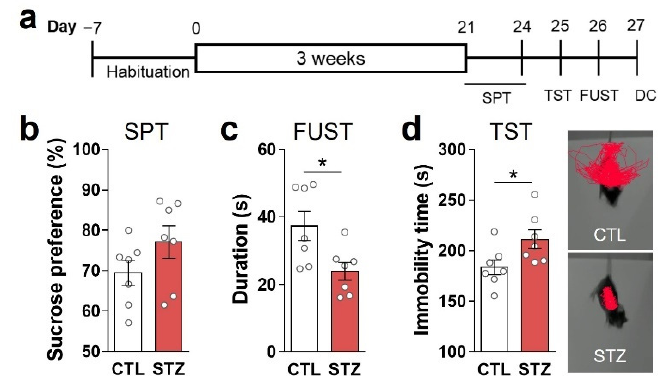
Figure 2. Hyperglycemia caused anhedonic and despair behaviors. ( a ) Experimental design. ( b ) Su- crose preference test (SPT). ( c ) Female urine sniffing test (FUST). ( d ) Tail suspension test (TST): immobility time and representative movement-tracking images. Data are presented as mean ± SEM. * p < 0.05 between indicated groups according to Student’s t -test. n = 8/group.